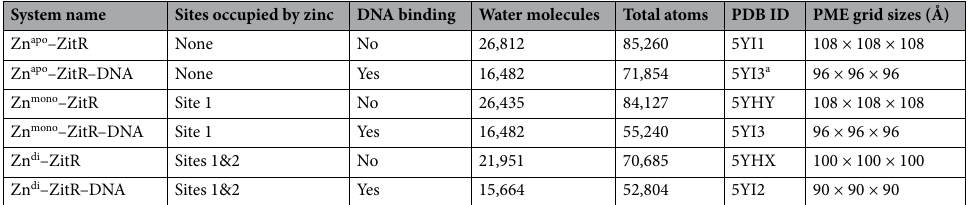
Table 1. Summary of MD simulation systems. a Zn apo –ZitR–DNA system was constructed by the deletion of zinc ions of Zn mono –ZitR–DNA